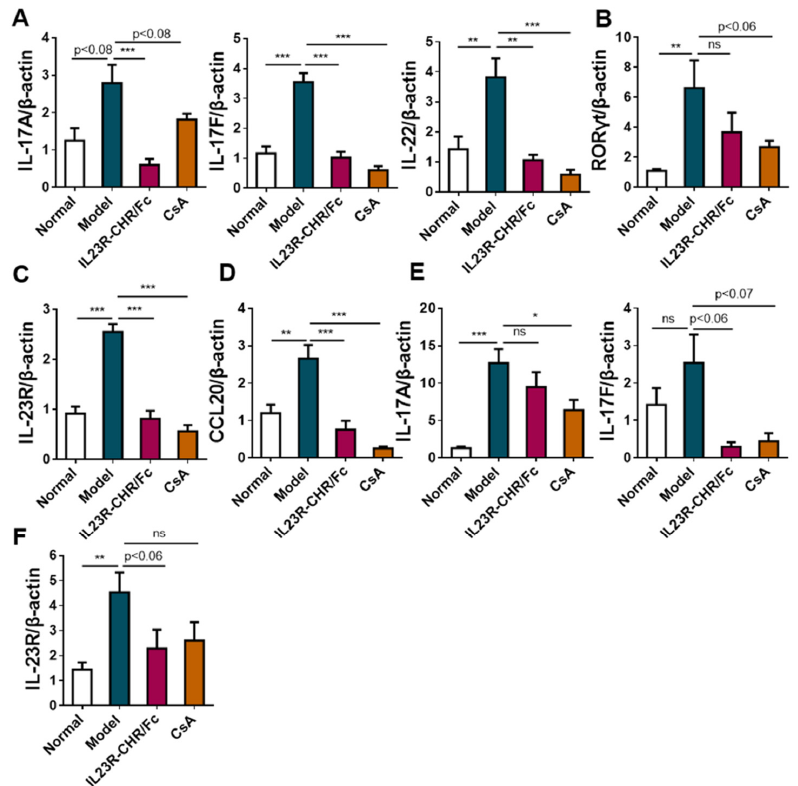
Figure 5. rhIL-23R-CHR / Fc inhibited the transcriptional levels of inflammatory-associated cytokines, transcription factors, and chemokines in mouse skin and spleen. ( A – D ) The mRNA expression of IL-17A, IL-17F, IL-22 ( A ), Ror γ t ( B ), IL-23R ( C ) and CCL20 ( D ) in skin lesions from normal or mice treated with IMQ ( n > 3). ( E , F ) The mRNA expression of IL-17A, IL-17F ( E ), and IL-23R ( F ) in spleen from normal or mice treated with IMQ. All results are representative of at least 3 independent experiments with at least 3 samples in each group. Data are mean ± SEM. * p < 0.05, ** p < 0.01 and *** p < 0.001. ns, not significant (Student’s t